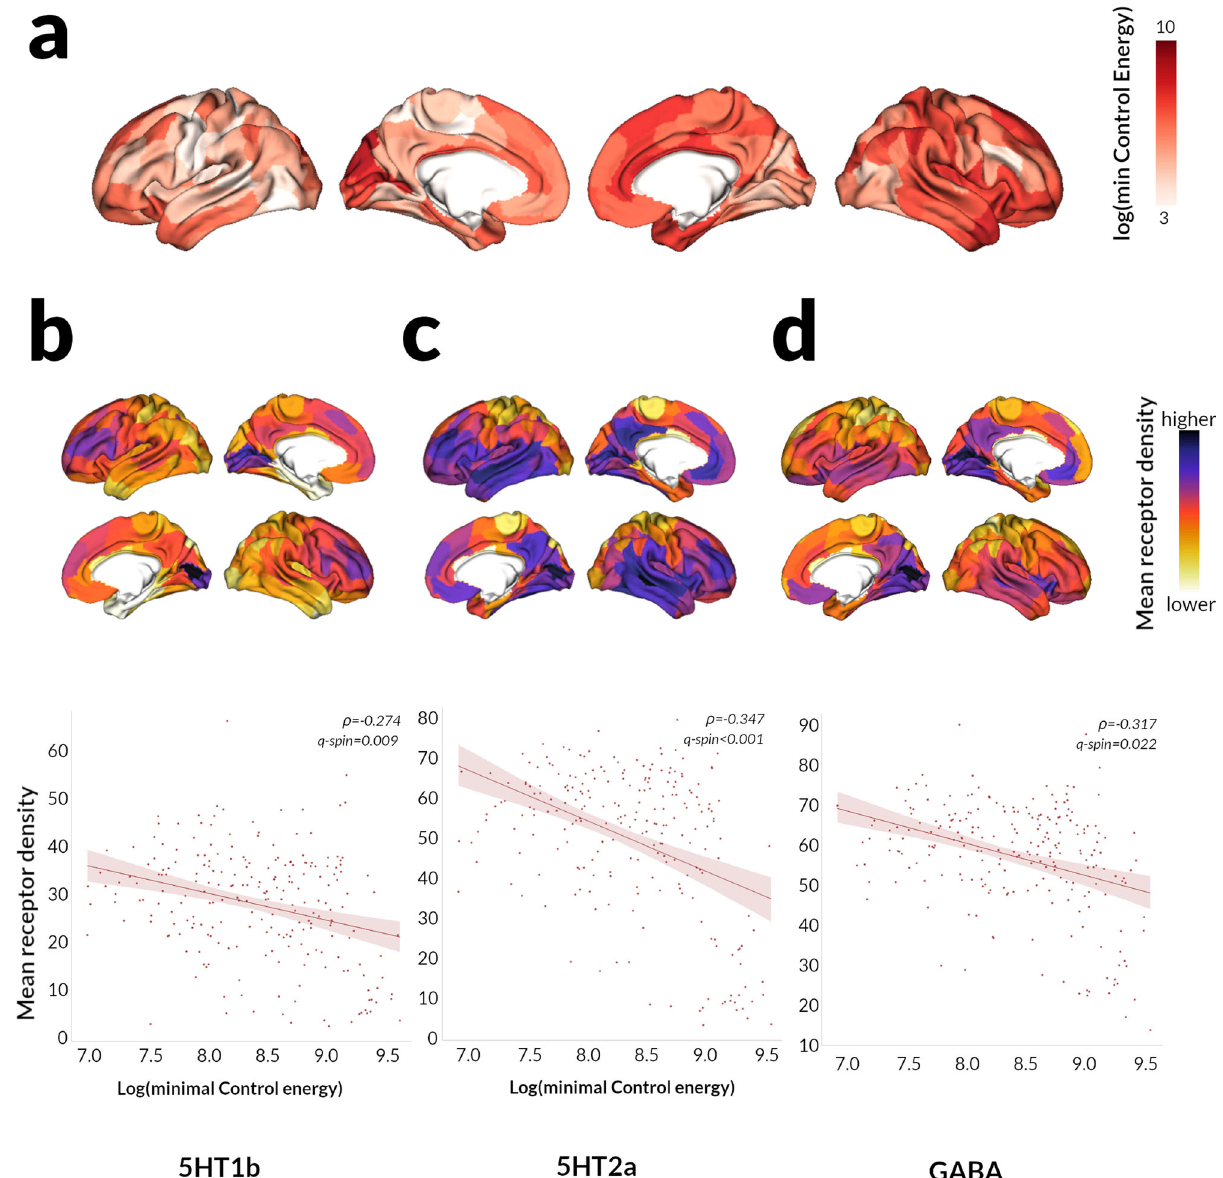
Fig. 4 Neurotransmitter correlates of Integrated-to-Segregated state transition. The log-transformed minimal control energy that needs to be applied to each node ( n = 232 nodes) to achieve the Integrated-to-Segregated state transition ( a ) was correlated with the mean regional receptor density of 5HT1b receptors ( b ), 5HT2a receptors ( c ) and GABA receptors ( d ), from open access atlases of PET data in unaffected individuals. In all cases, ρ is the Spearman correlation coef fi cient and q -spin is the FDR-corrected p -value derived following spatial permutations ( p -spin, 1000